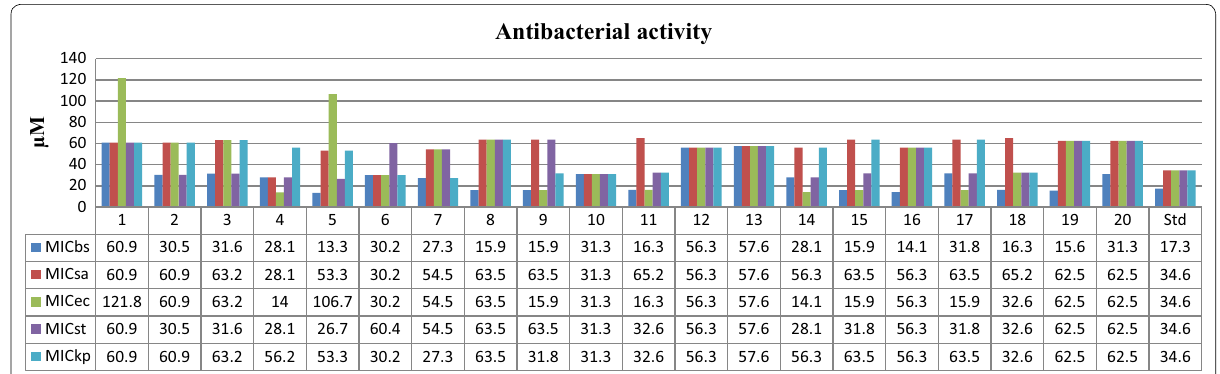
Fig. 2 Antibacterial screening results of the synthesized benzoxazole